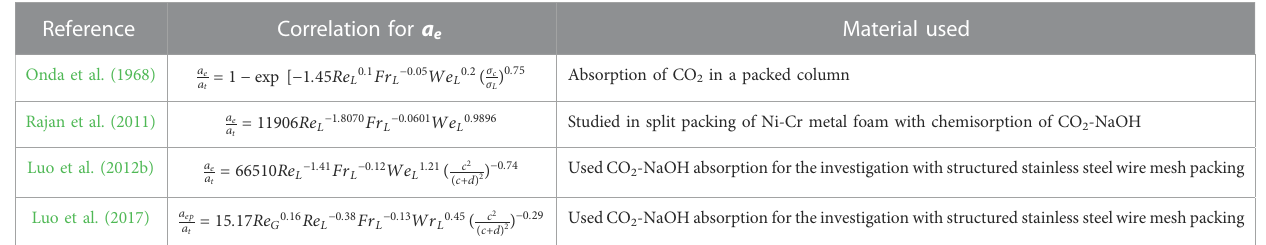
TABLE 6 Effective interfacial surface area.